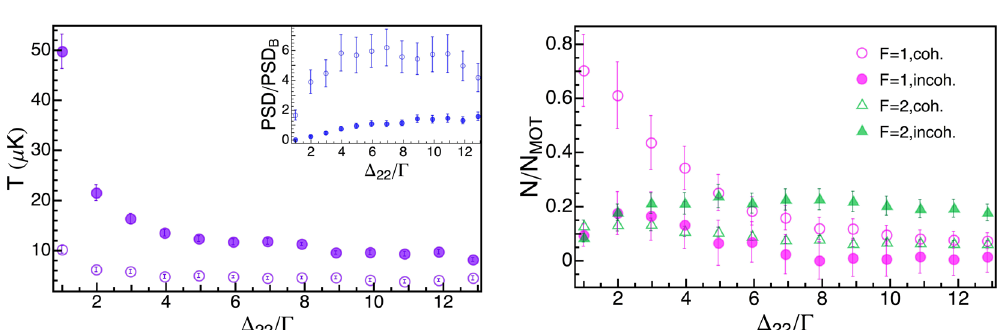
Figure 4. Influence of detuning: incoherent and coherent repumper. Left: Temperature T ( PSD / PSD B is shown in the inset) as a function of the cooler and rempumper detuning. We report both the case of coherent (empty points) and incoherent repumper (filled points). Right: Fractional number of remaining atoms N / N MOT in F = 1 (pink circles) and F = 2 (green triangles); empty (filled) points refer to the case of coherent (incoherent)